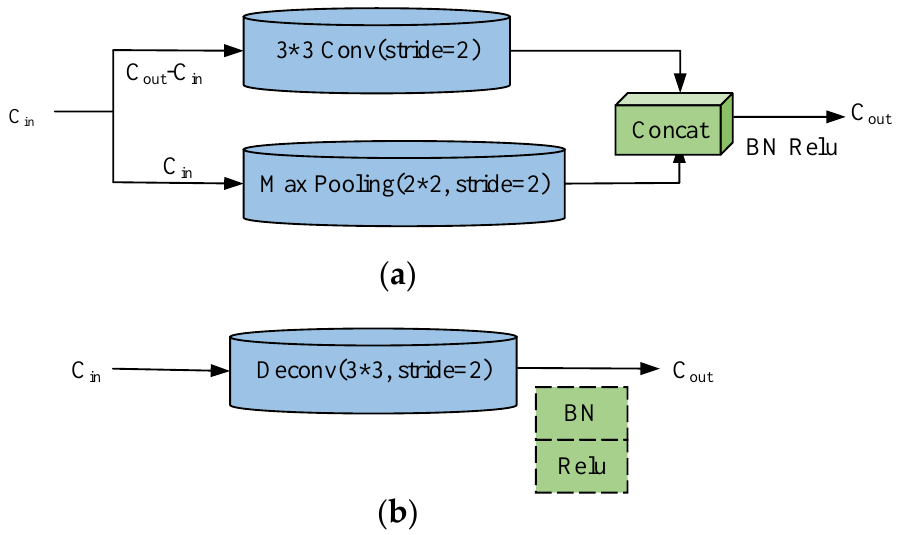
Figure 10. Structure of up-sampling module and down-sampled module: ( a ) up-sampling module; ( b ) down-sampled module.